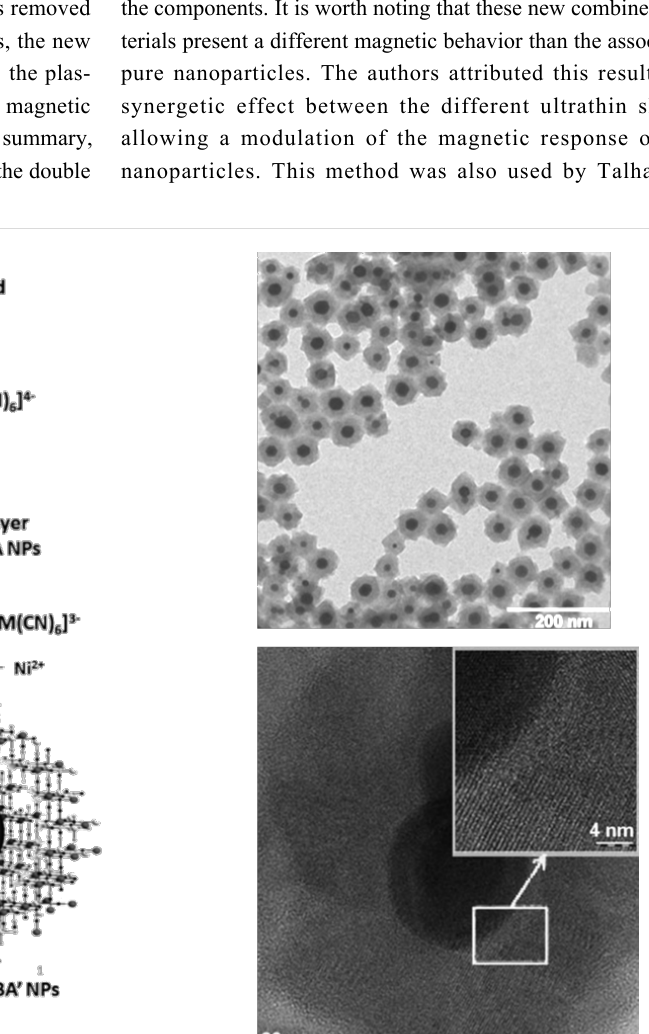
As far as we know, the second and third types of core–shell analog complexes (PBA). While not all of these compounds are